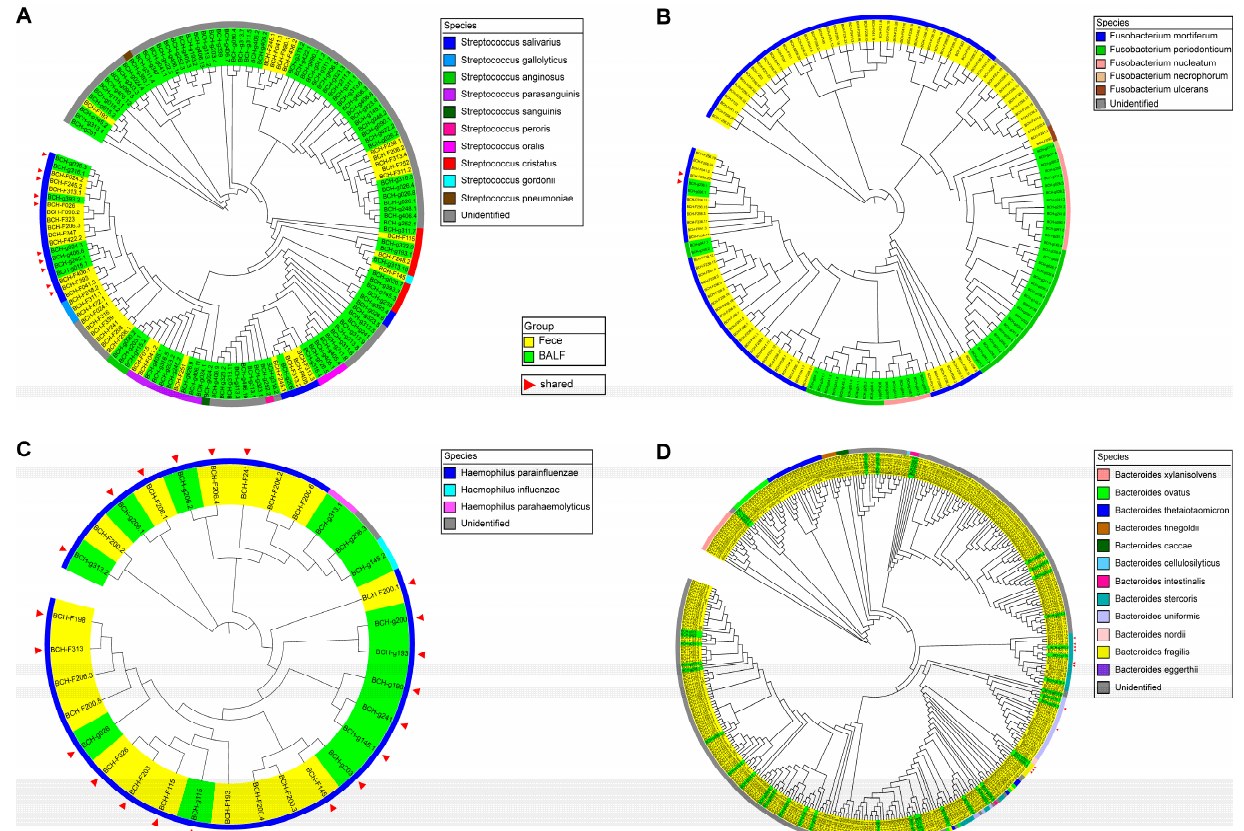
Figure 5. Phylogenetic analysis of the genera Streptococcus ( A ), Fusobacterium ( B ), Haemophilus ( C ), and Bacteroides ( D ) with characteristic 16S rRNA gene sequences of paired fecal and BALF samples in patients with LADC. Yellow and green represent the sequences of fecal and BALF samples, respectively. The different colors in the outermost circle represent annotated species. Red triangles represent the sequences present in both the lung and gut samples from the same patient. The phylogenetic analysis was conducted using FastTree 2.1.10 software.